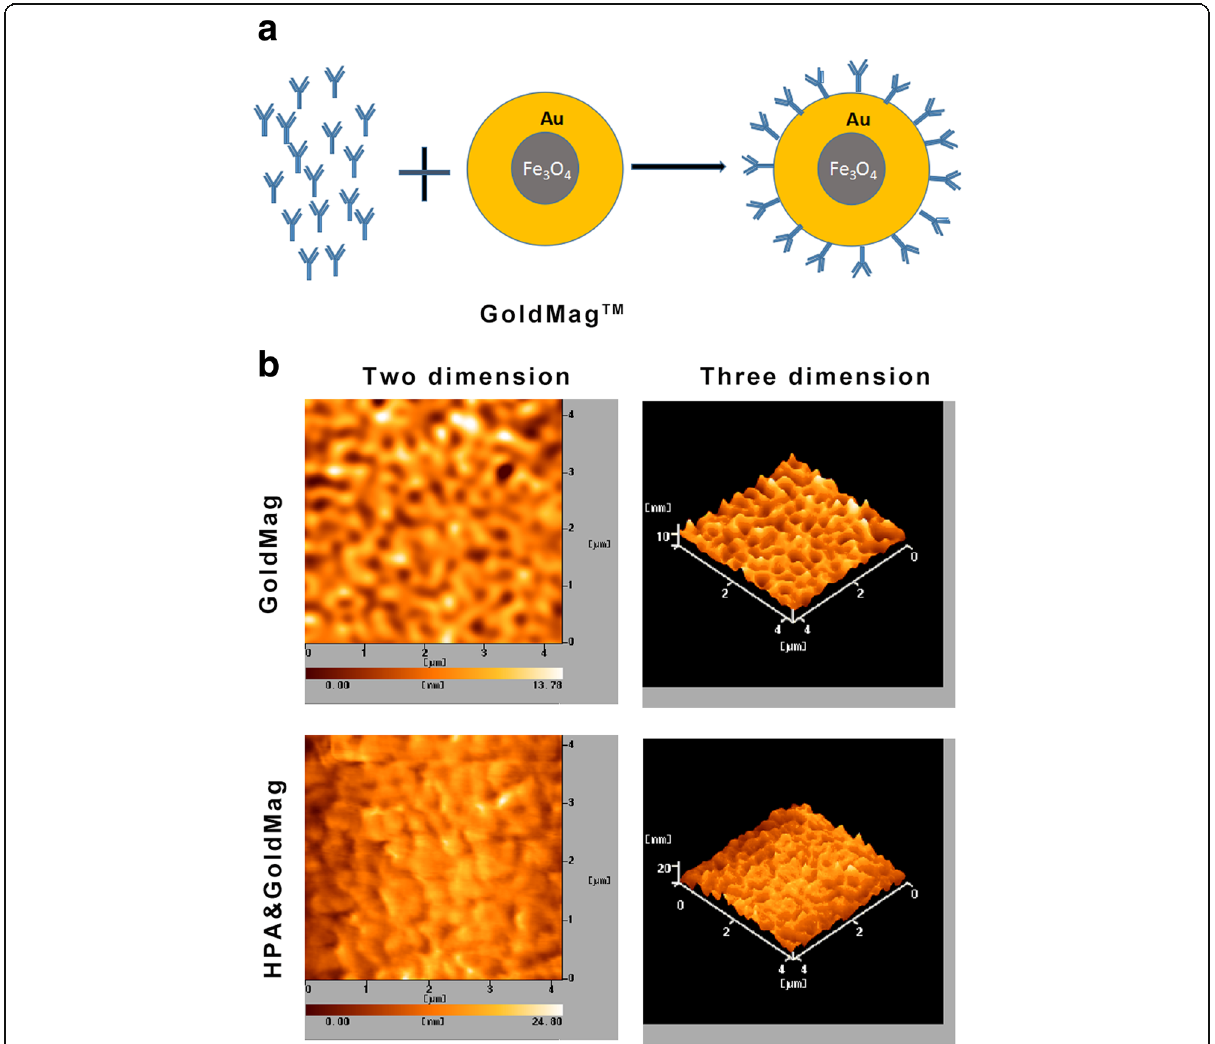
Fig. 2 a Model of coupling magnetic gold nanoparticles with HPA mAbs. b Atomic force scanning of magnetic gold